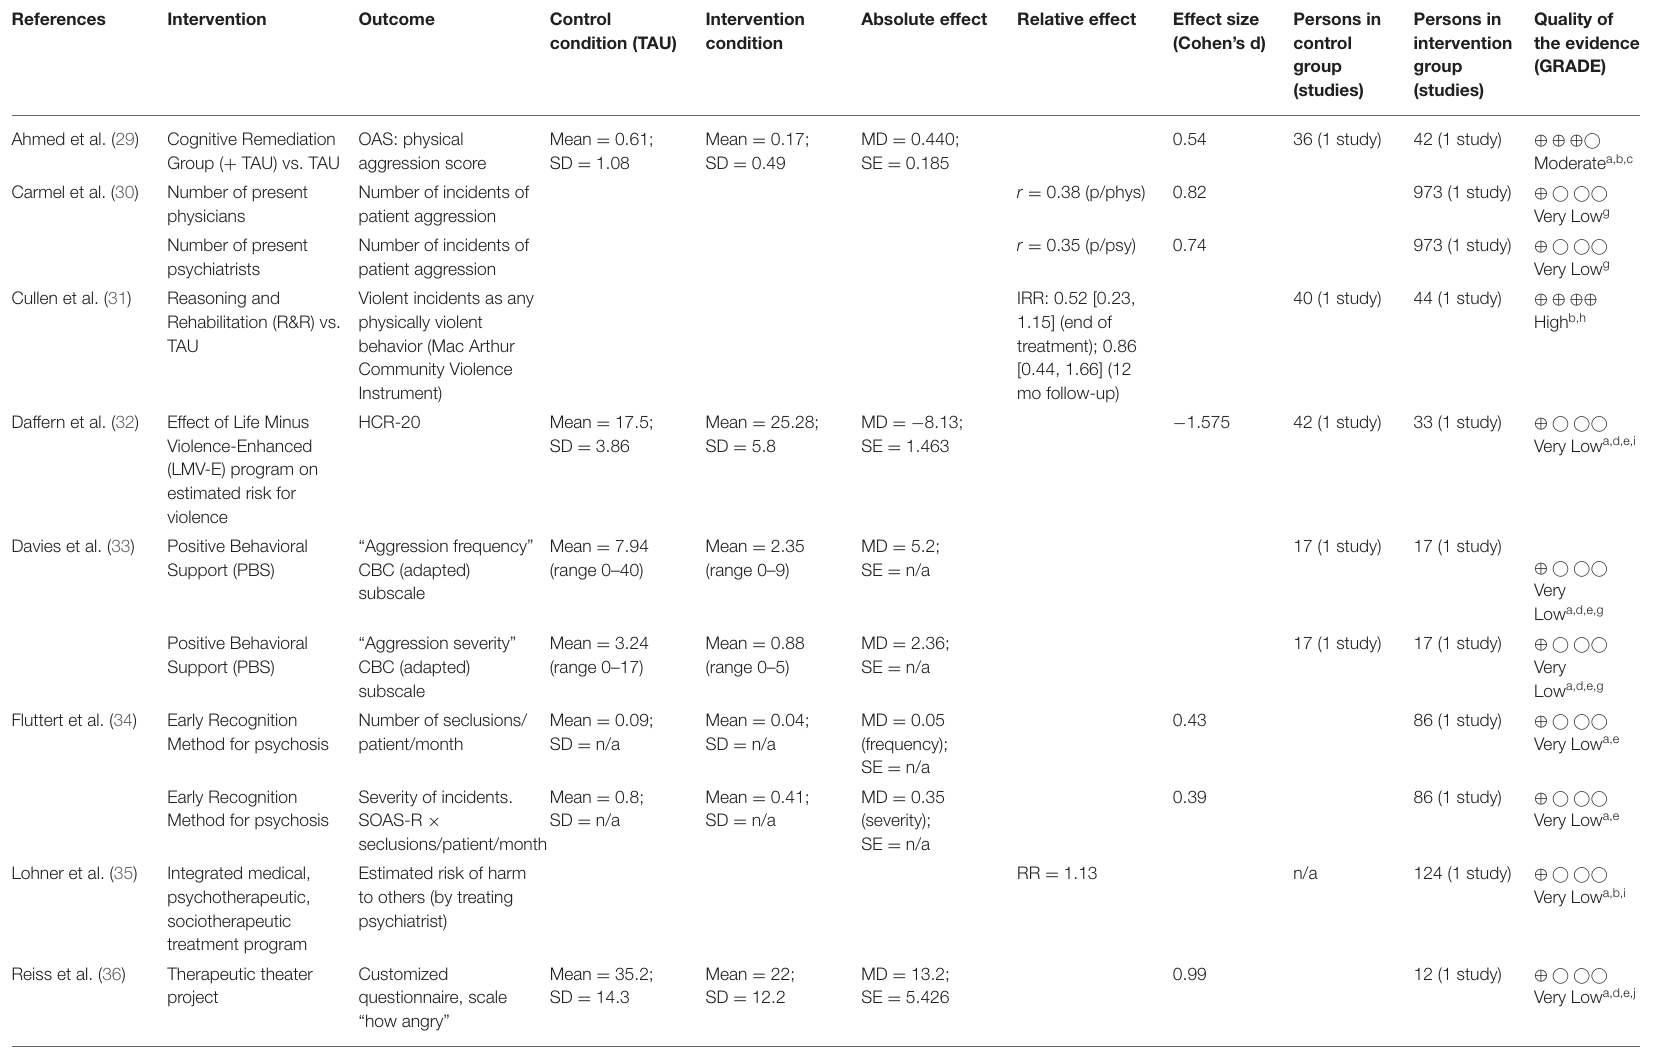
TABLE 2 | Effects of non-pharmacological trials (Treatment as usual =